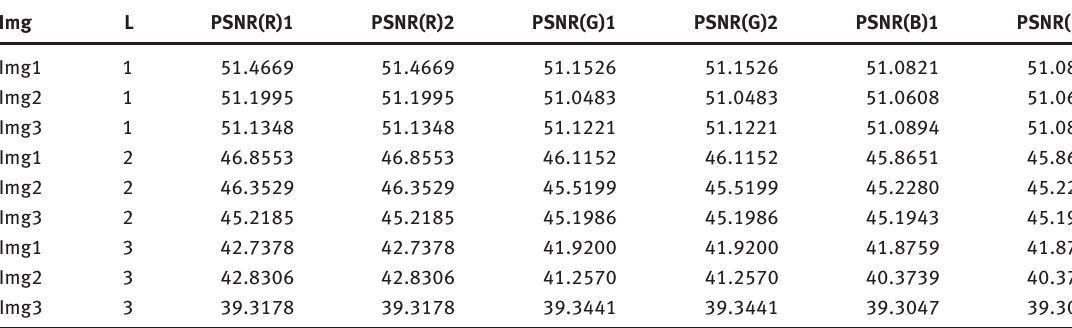
Table 5: Comparative Study of Both Parallel and Nonparallel Algorithms based on Image